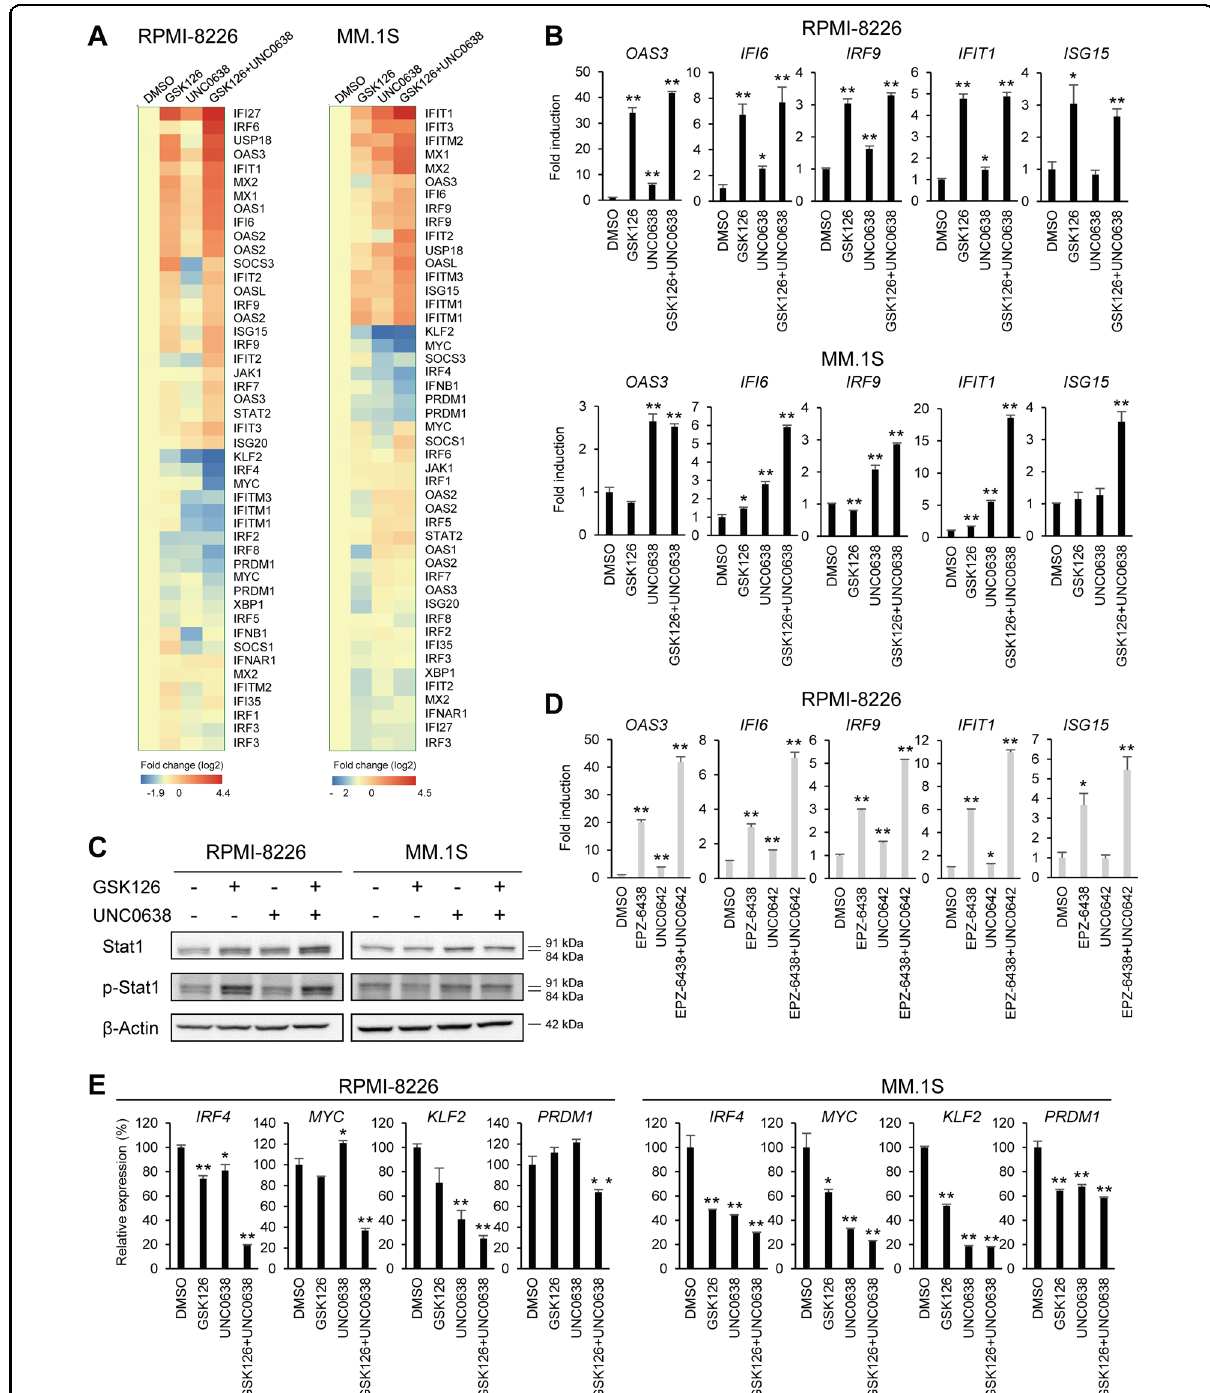
Fig. 4 Upregulation of ISGs and suppression of IRF4-MYC axis genes by EZH2 and G9a inhibition in MM cells. A Heat maps for expression of ISGs and IRF4-MYC axis genes in MM cell lines treated with the indicated drugs (1 μ M each, 6 days). B qRT-PCR analysis of ISGs. Results are normalized to cells treated with DMSO. Shown are means of three technical replications; error bars represent SEMs. C Western blot analysis of Stat1 and phosphorylated Stat1. D qRT-PCR analysis of ISGs in RPMI-8226 cells treated with EPZ-6438 and/or UNC0642. Results are normalized to cells treated with DMSO. Shown are means of three technical replications; error bars represent SEMs. E qRT-PCR analysis of IRF4-MYC axis genes. Results are normalized to cells treated with DMSO. Shown are means of three technical replications; error bars represent SEMs. * P < 0.05, ** P <